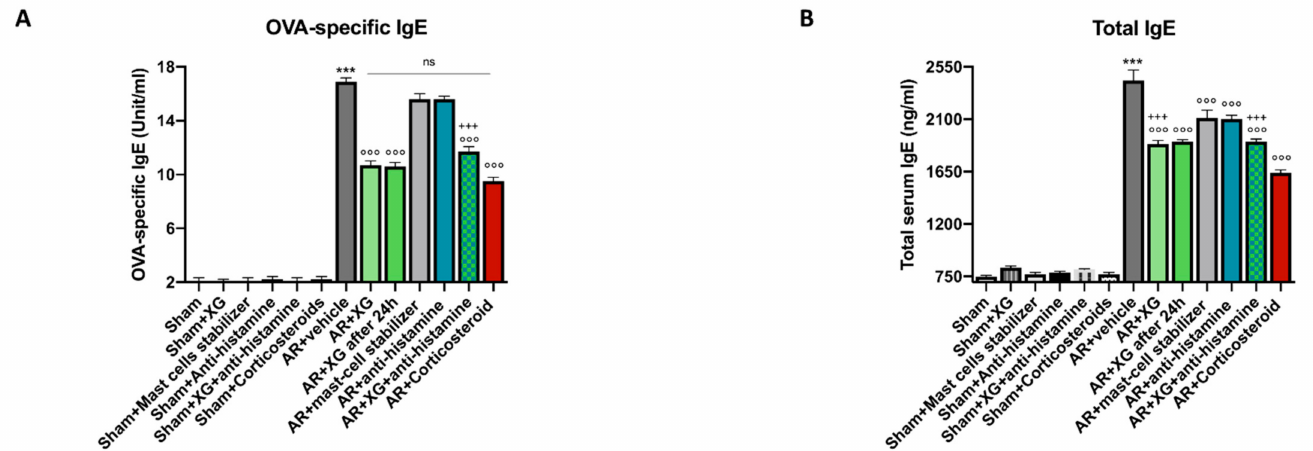
Figure 6. Effect of XG on OVA-specific and total serum IgE levels. Increased levels of IgE were found in the serum of AR-mice compared to the sham animals. The XG-based spray was able to markedly reduce serum total and OVA-specific IgE in a way comparable to mast cell stabilizer and antihistamine single treatments ( A , B ). In addition, co-treatment consisting of XG and antihistamine effectively modulated IgE, OVA-specific and total serum levels, similarly to treatment with corticosteroid ( A , B ). Data are representative of at least three independent experiments. Values are means ± SEM. One-Way